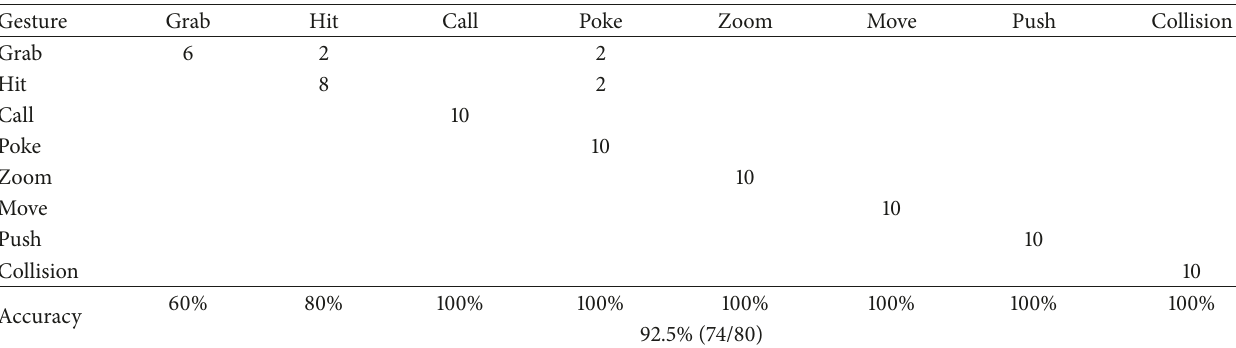
Figure 27: The example of eight gesture classes. The beginning and ending frames are shown, and the moving directions are shown in blue arrows. Table 12: Confusion matrix for gesture recognition on the testing